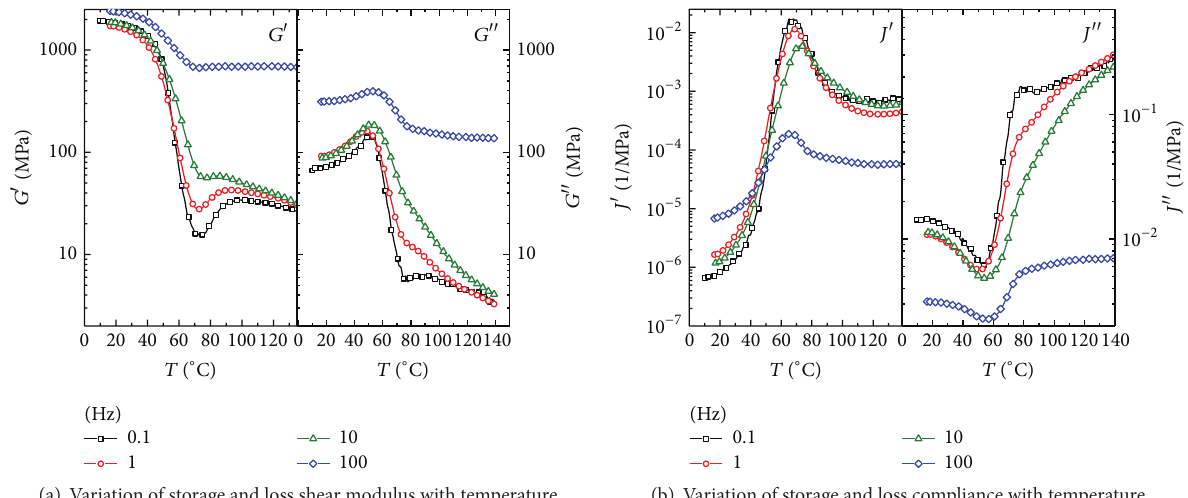
Figure 3: Temperature sweep tests at different frequencies.